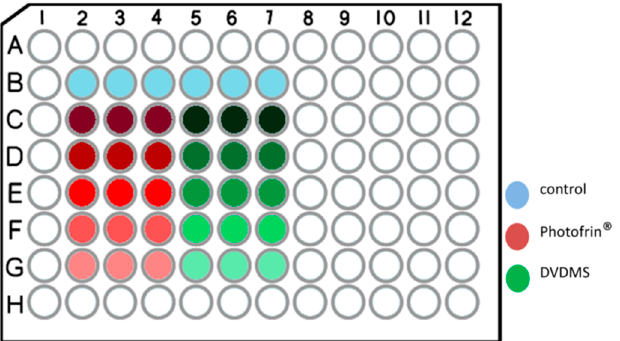
Figure 6. The 96-well plate configuration of MTT assay. Plate configuration: Blue, Row B from B2 to B7 was control groups, which were incubated with 0.9% NaCl. Red panel indicated positive control of Photofrin ® : Row C, from C2 to C4, concentration = 100 μ g/mL; Row D, from D2 to D4, concentration = 10 μ g/mL; Row E, from E2 to E4, concentration = 1 μ g/mL; Row F, from F2 to F4, concentration = 0.1 μ g/mL; Row G, from G2 to G4, concentration = 0.01 μ g/mL; Green panel indicated sinoporphyrin sodium (DVDMS): Row C, from C5 to C7, concentration = 10 μ g/mL; Row D, from D5 to D7, concentration = 1 μ g/mL; Row E, from E5 to E7, concentration = 0.1 μ g/mL; Row F, from F5 to F7, concentration = 0.01 μ g/mL; Row G, from G5 to G7, concentration = 0.001 μ g/mL.